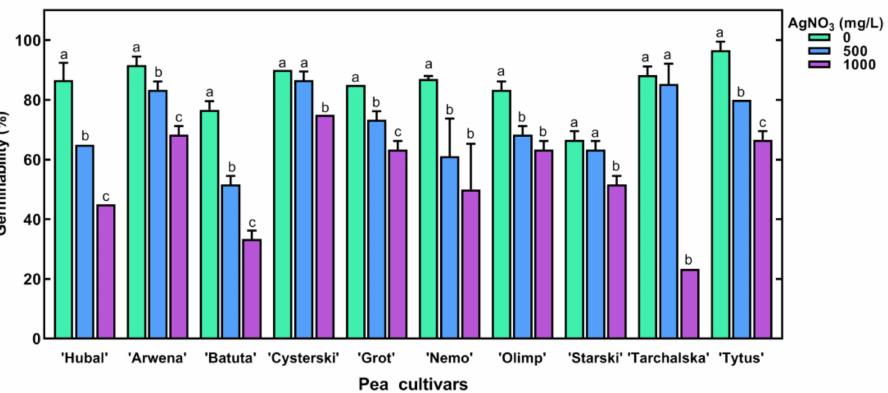
Figure 3. The effect of seed imbibition of ten pea cultivars in AgNO 3 at concentrations of 0, 500 and 1000 mg/L for 8 h on their germinability. Results are means ( n = 3) + SD. The same letters (a–c) above the bars indicate no significant ( p < 0.05) differences according to ANOVA and Tukey post-hoc